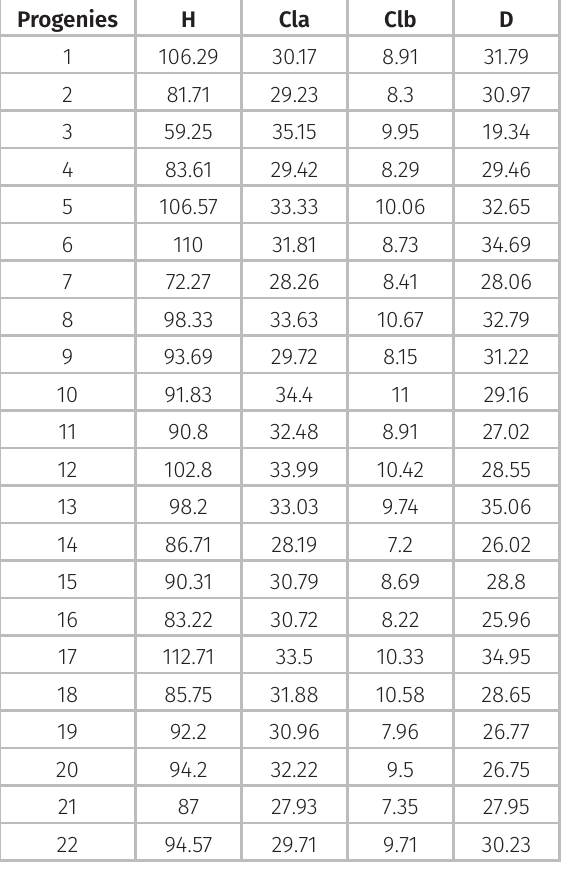
Table I. Total height (H), chlorophyll-a (Cla), chlorophyll-b (Clb), and diameter at soil level (D) of 22 Khaya senegalensis